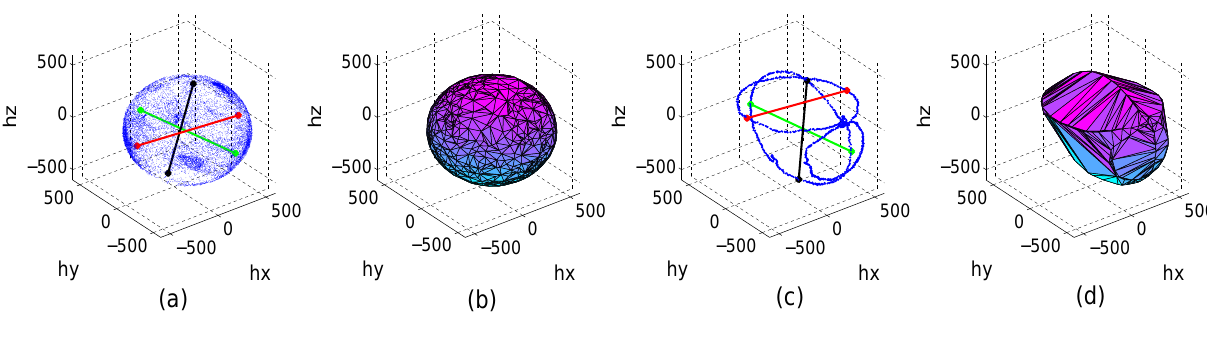
Figure 7. Well distributed dataset: Euclidean distances ( a ), Convex hull ( b ). Ill-distributed dataset: Euclidean distances ( c ), Convex hull ( d